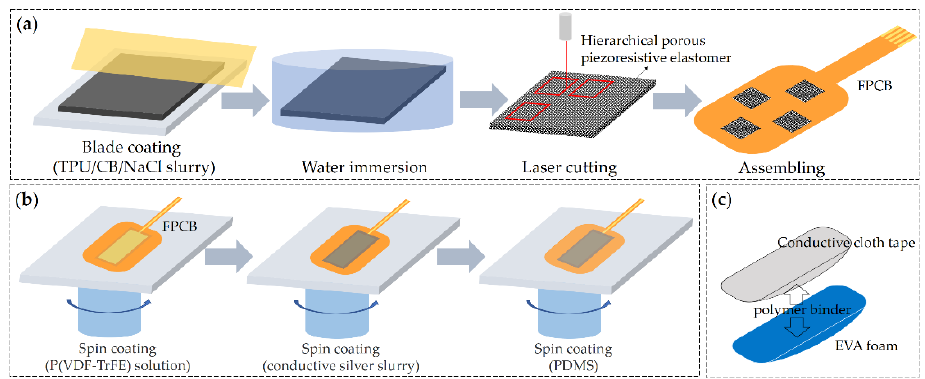
Figure 2. Fabrication of the individual devices, including: ( a ) piezoresistive sensor array, ( b ) piezo- electric sensor, and ( c ) triboelectric sensor.